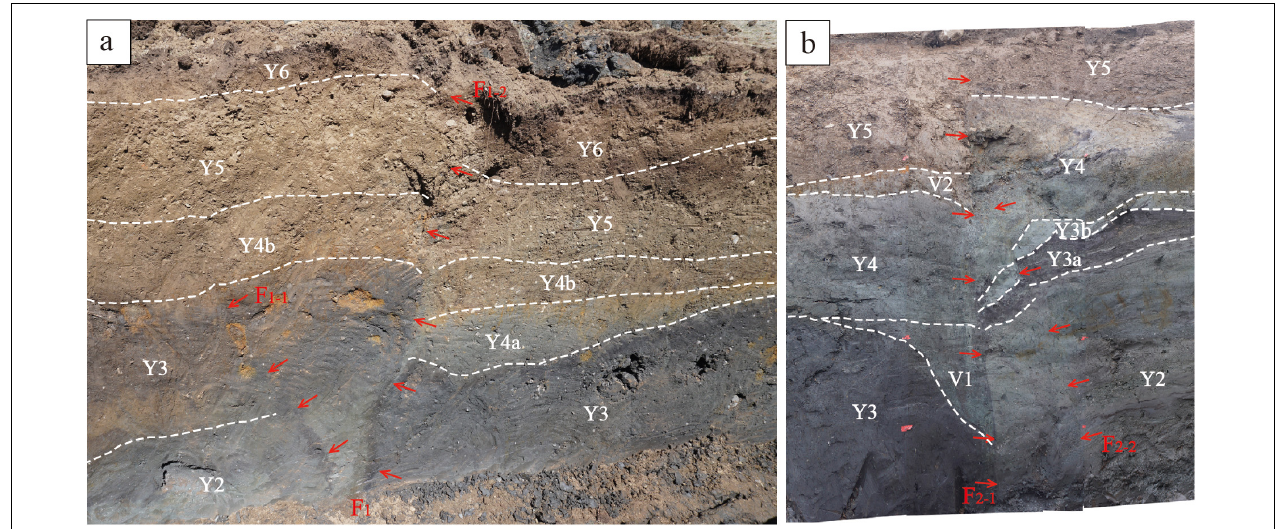
FIGURE 6 | Photographs of parts of the walls of TC1: (a) part of the northwestern wall showing the relationship between fault F 1 and deformation of the strata, and (b) part of the southeastern wall showing the relationship between fault F 2 and deformation of the strata. White dashed lines mark stratigraphic boundaries; red arrows indicate fault